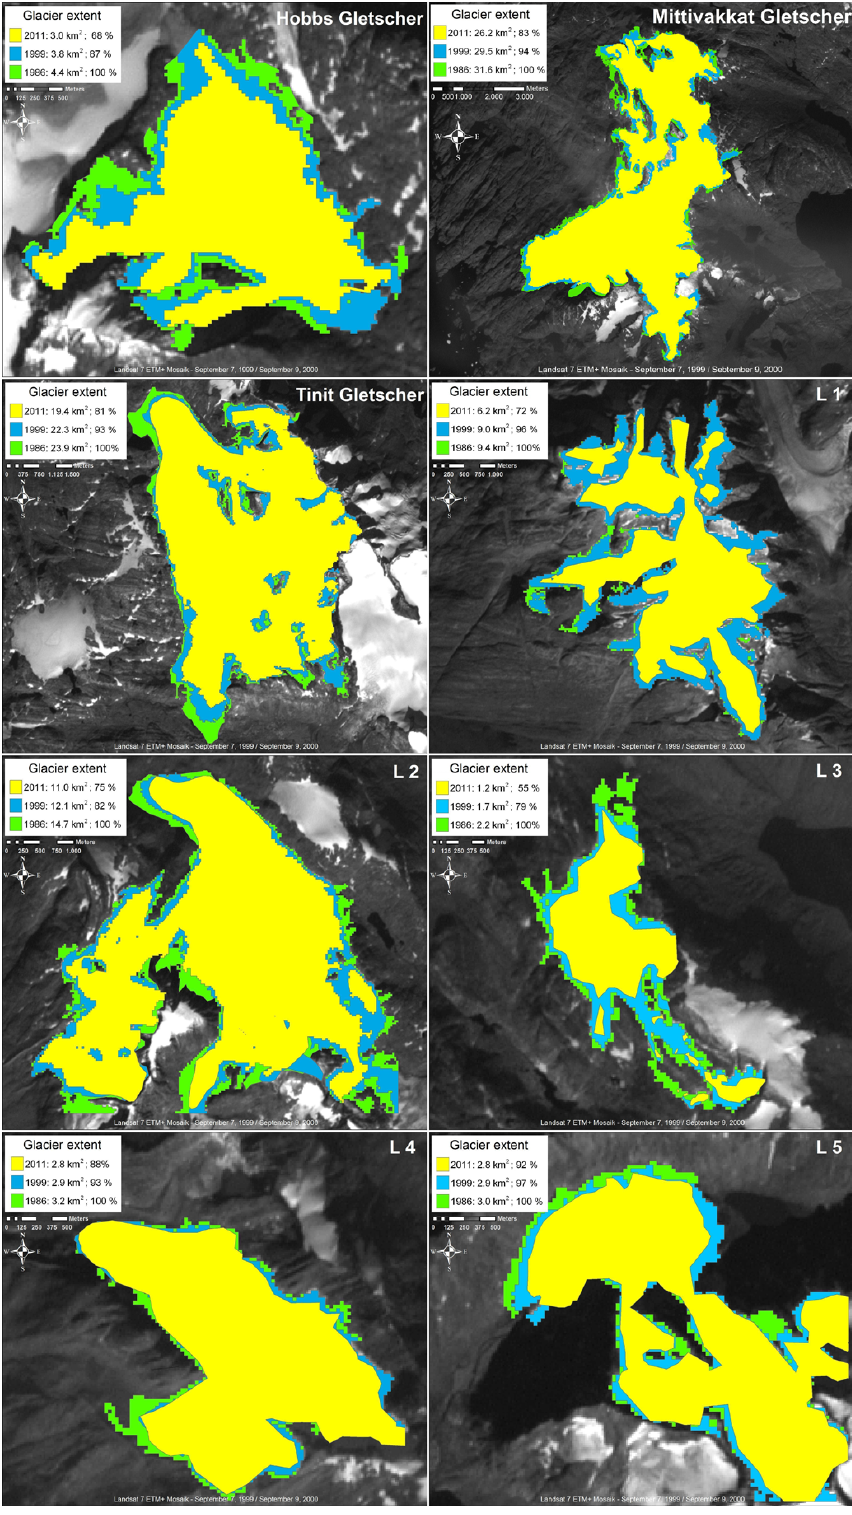
Fig. 11. The margin location of eight land-terminating GIC (peripheral to the GrIS) in the Ammassalik region: Hobbs, Mittivakkat, Tinit, and L1–L5 glaciers for the survey years 1986 (green), 1999 (blue), and 2011 (yellow) estimated from Landsat images. The location of the individual glaciers is shown in Fig. 1 (source: Landsat 7 ETM+ Mosaik, 7 September 1999/9 September 2000).